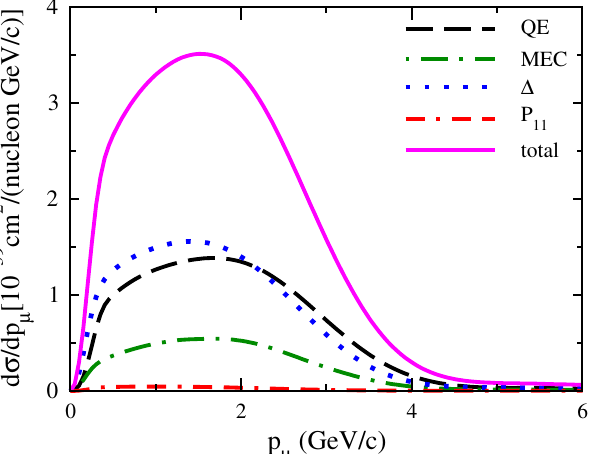
Figure 8. The SuSA predictions for inclusive single differential ( ν µ , µ − ) cross-section off 40 Ar, averaged over the DuNE flux, are displayed versus the muon momentum p µ . The separate QE, MEC, ∆ and P 11 contributions are